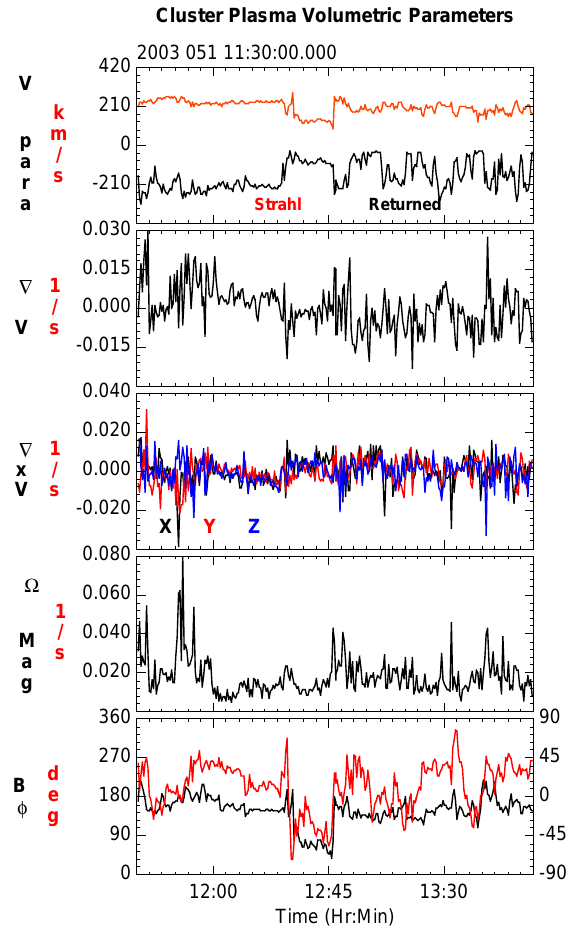
Fig. 7. In descending order: the reduced parallel velocity of the C1 strahl and return electrons, the electron compression, three GSE components of the electron vorticity, the magnitude of the vorticity and the φ and θ GSE components of the C1 magnetic